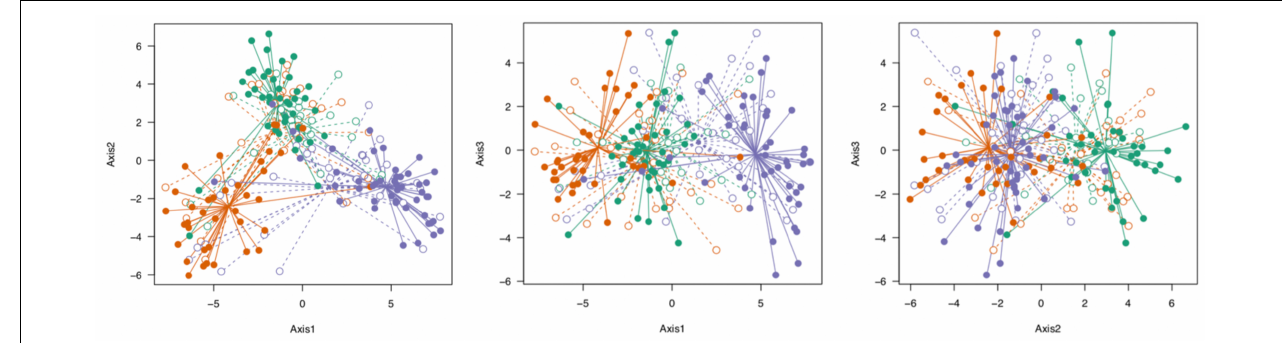
FIGURE 4 | Visualization of the genetic structure of S. alterniflora populations by PCA (PC1 explains 16.5% of the variation, PC2 explains 8%, and PC3 explains 4.6%). We used only the top 5% most differentiated SNPs based on Jost’s D (Jost, 2008), and only SNPs without missing values ( N = 80). Each dot represents one stem; populations are indicated by color (Green = Bowens Island, Red = Folly Beach, Blue = Fort Johnson) and habitats are filled (low marsh plants) or open (high marsh plants). See also Supplementary Figure 2 for similar depiction of epigenetic structure of populations.